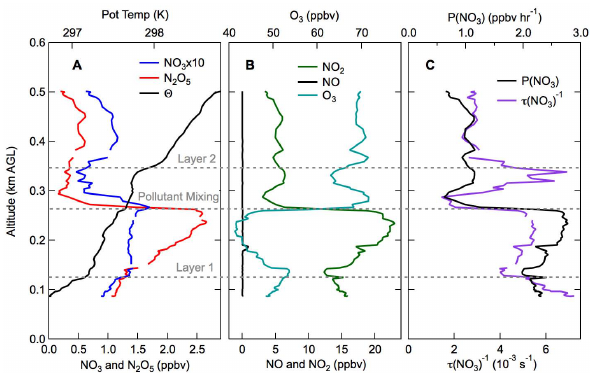
Fig. 3. Vertical profiles: (A) mixing ratios of NO 3 ( × 10 to make it visible) and N 2 O 5 (bottom axis) and potential temperature (top axis); (B) mixing ratios of NO and NO 2 (bottom axis) and O 3 (top axis); (C) NO 3 reactivity, measured as τ (NO 3 ) − 1 (bottom axis) and production rate, P (NO 3 ) (top axis). Data are for descent to Hooks on 8 October, 09:33 local time. Grey dashed lines and labels indicate altitudes of layers in the potential temperature profile and in the observed mixing of pollutants (see